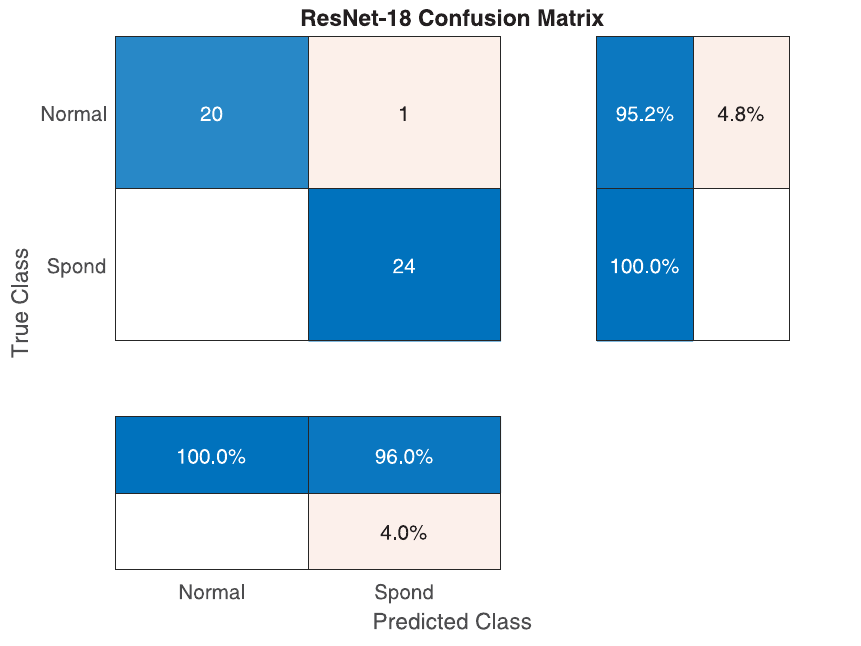
Fig 8. The RestNet-101 sample confusion matrix for normal vs spondylolisthesis classification.